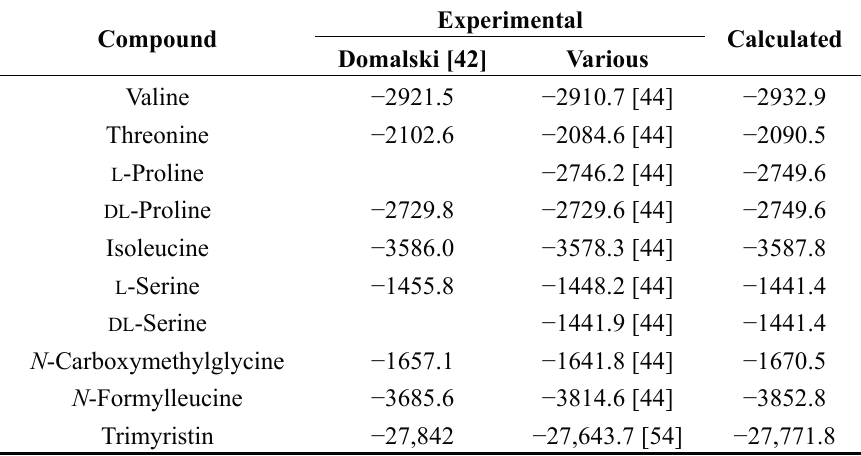
Table 4. Heat-of-Combustion: Experiment vs. Calculation (in